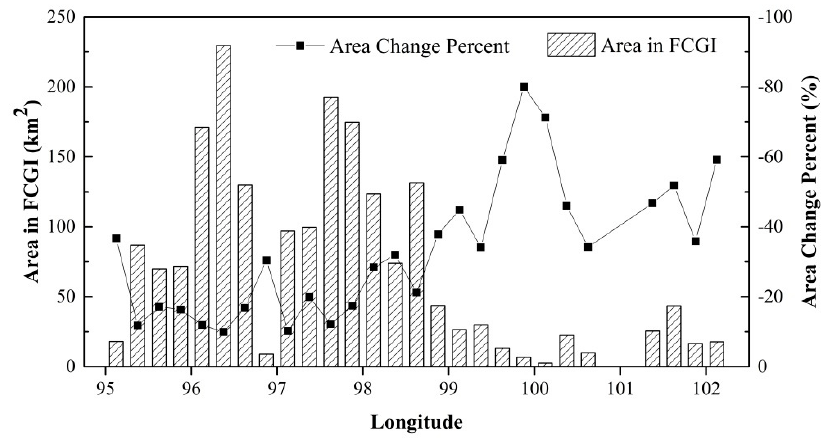
Figure 5. The area change percentage in glaciers in the Qilian Mountains from the 1960s to 2015.